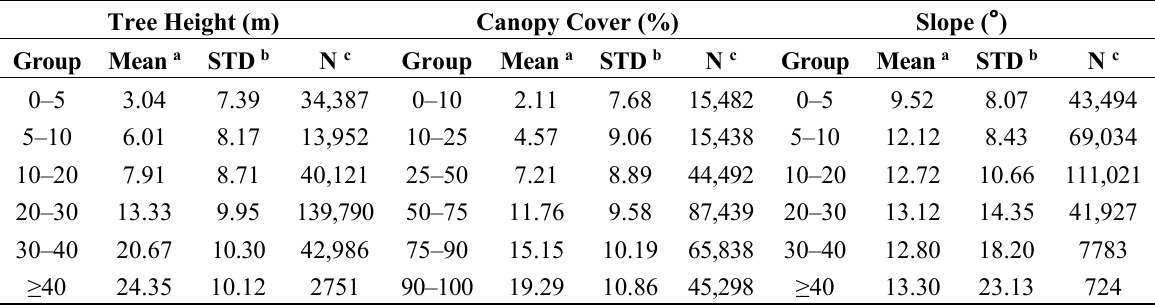
Table 2. Statistics for differences between the SRTM DEM and the LiDAR DEM (SRTM DEM minus LiDAR DEM), classified by tree height, canopy cover and slope.